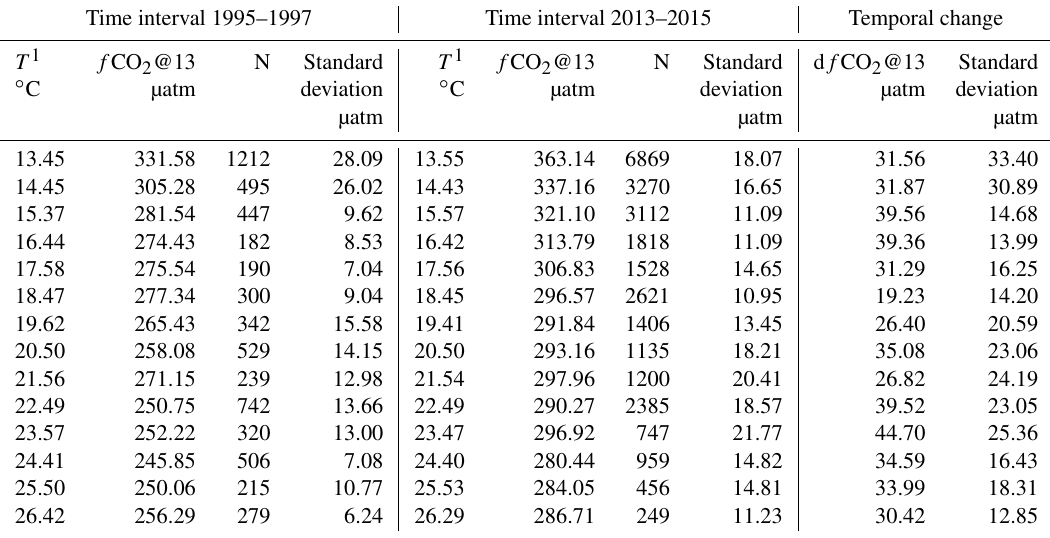
Table 1. Distribution of temperature, f CO 2 @13, and increase d f CO 2 @13 data binned by 1 ◦ C temperature interval for the two